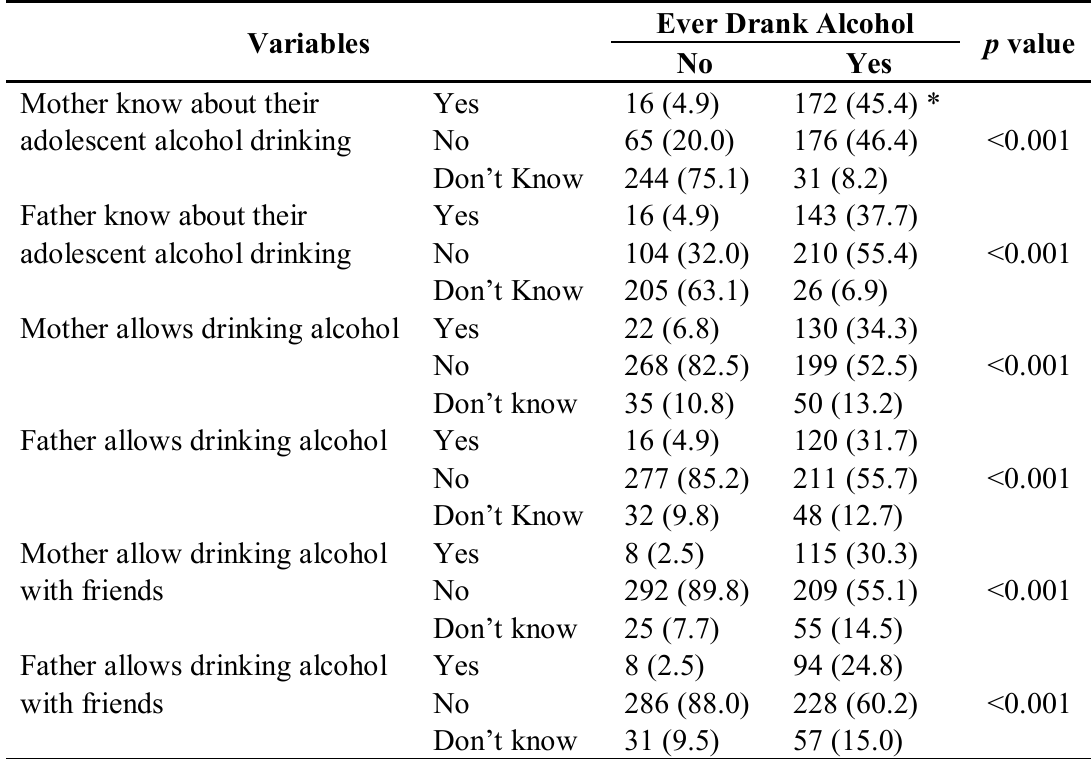
Table 3. Adolescents’ perception on parental awareness and acceptance on adolescent alcohol